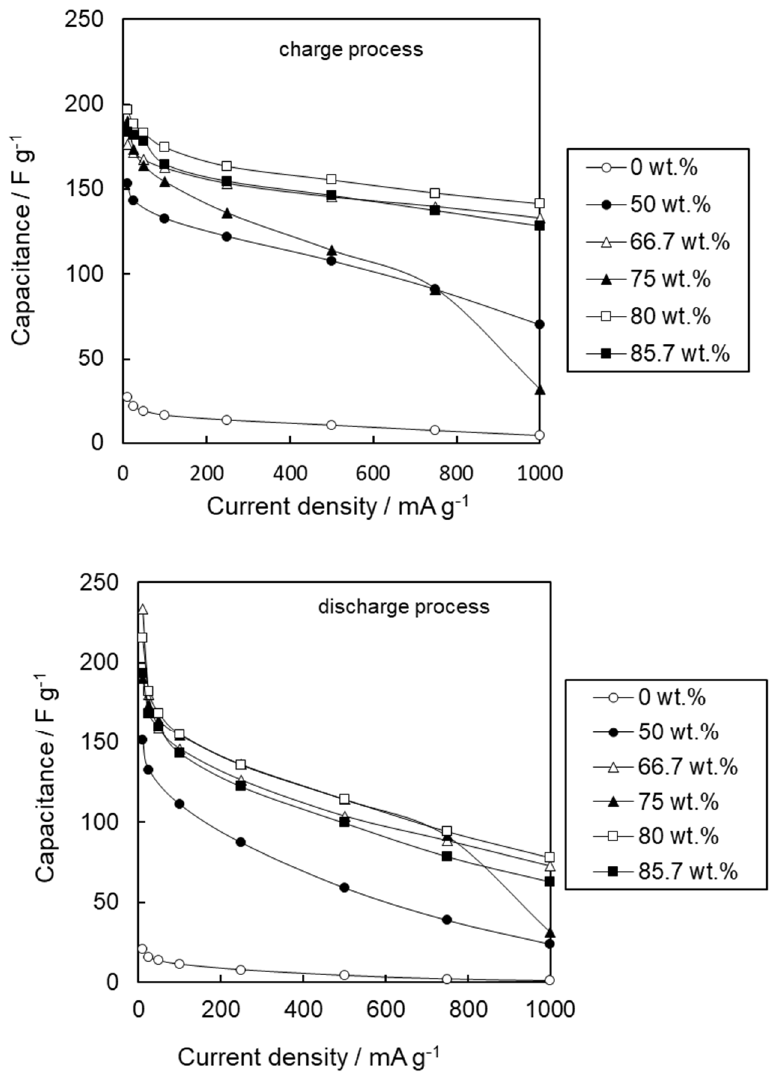
Figure 10. The capacitance values calculated from the data of charge-discharge measurements.